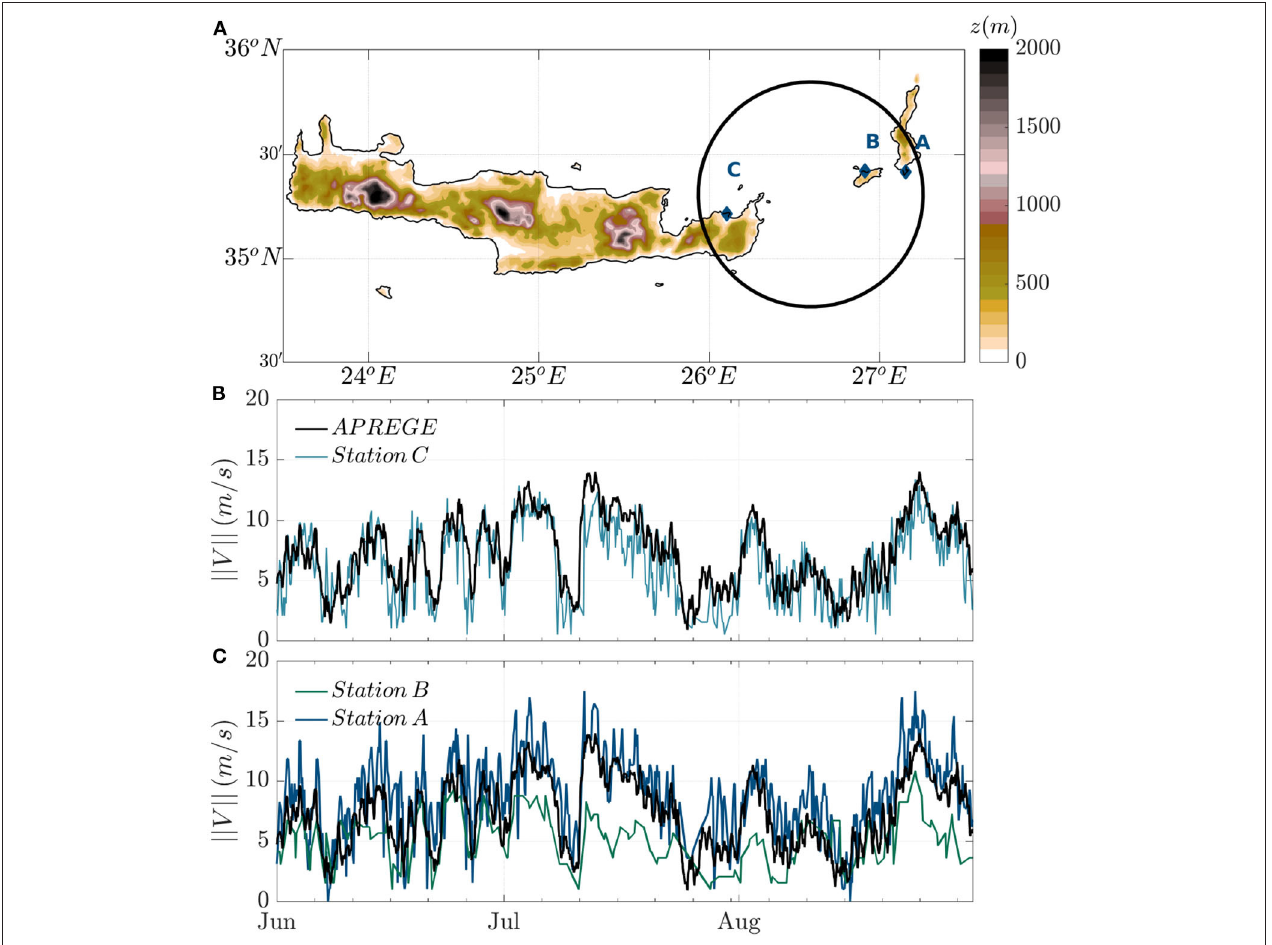
FIGURE 1 | (A) Elevation map (m) of Crete island from ETOPO2 dataset. The locations of the meteorological stations (HNMS); Karpathos (A), Kasos (B), and Sitia (C) are displayed with the blue diamond points. The selected area for analyzing the ARPEGE wind forcing climatology is illustrated with the black circle of R = 60 km . Time-series of wind speed ( m / s ), as extracted from the three meteorological stations (Station A, B, and C), are shown against the mean wind speed variations from ARPEGE data in (B,C)